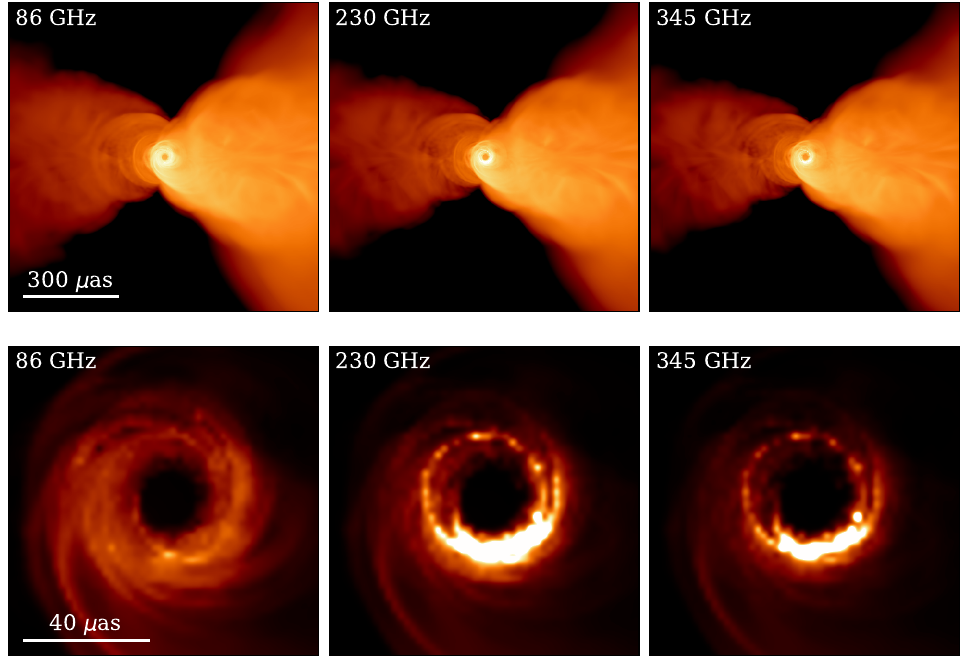
Figure 2. Input images used for the M87 synthetic data in this work, produced from the GRMHD simulations in [22]. The upper panels show a 1mas field of view with a logarithmic colorscale to highlight the extended jet emission, and the lower panels show the central 100 µ as around the black hole using a linear color scale to more easily see the photon ring